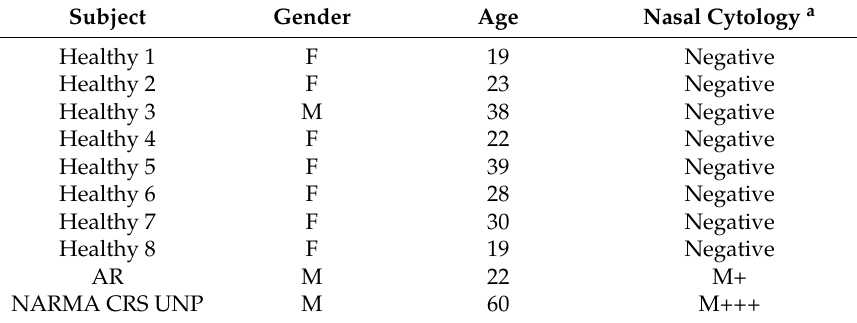
Table 2. Clinical characteristics of the examined